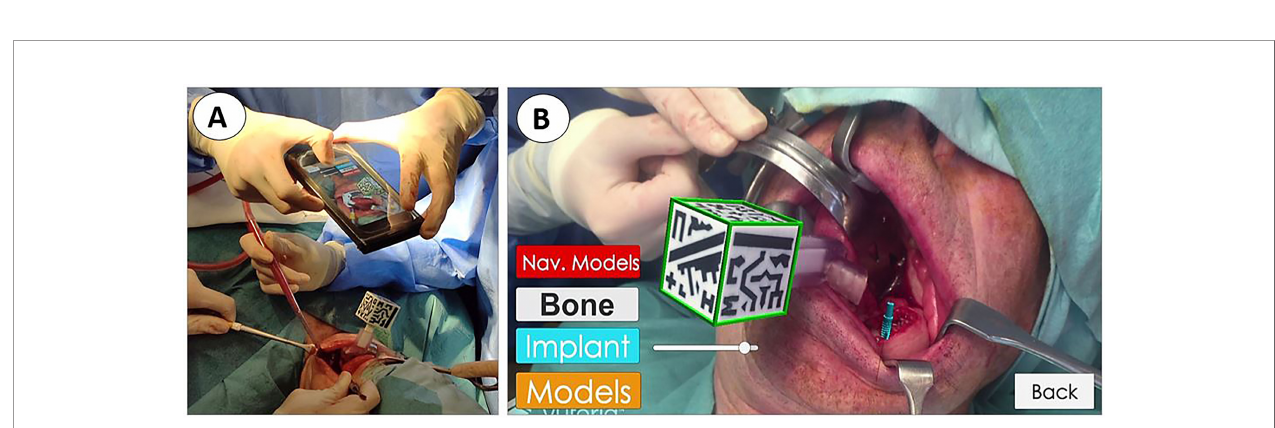
FIGURE 5 | Visualization layout during dynamic navigation. (A) 3D view of the handpiece position during drilling with respect to the virtual surgical plan. (B) 2D target view to control linear deviation of the handpiece tip at the entry crestal point. (C) 2D target view to control angular deviation of the drilling